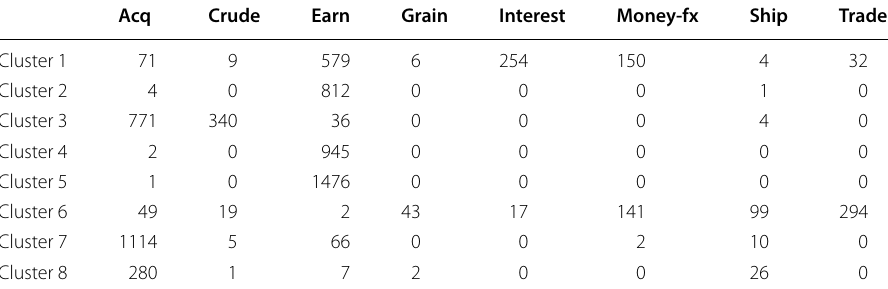
Table 14 The category distribution in clusters generated by Cosine similarity (R8, tf-idf)